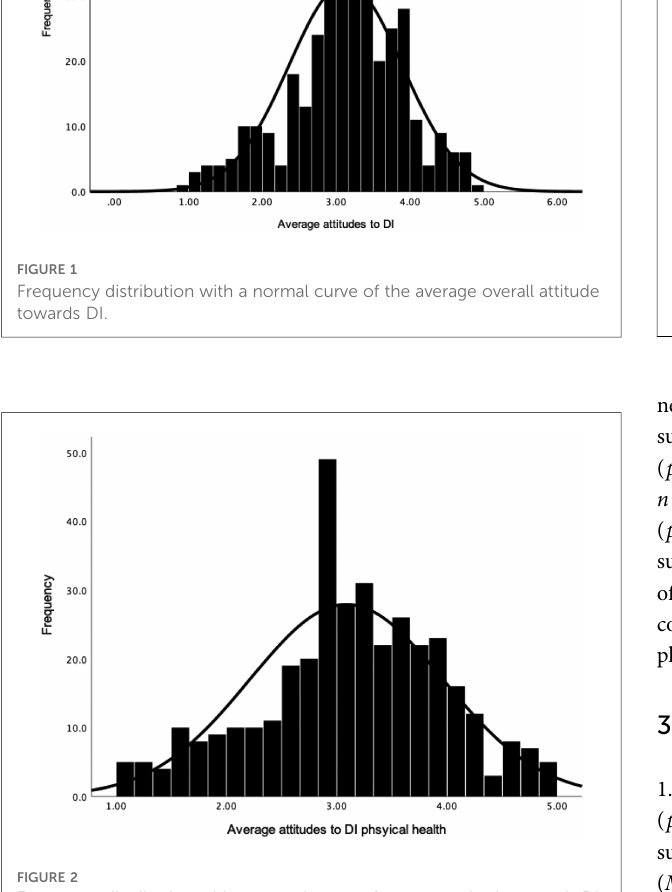
FIGURE 2 Frequency distribution with a normal curve of average attitude towards DI for physical health (PH).